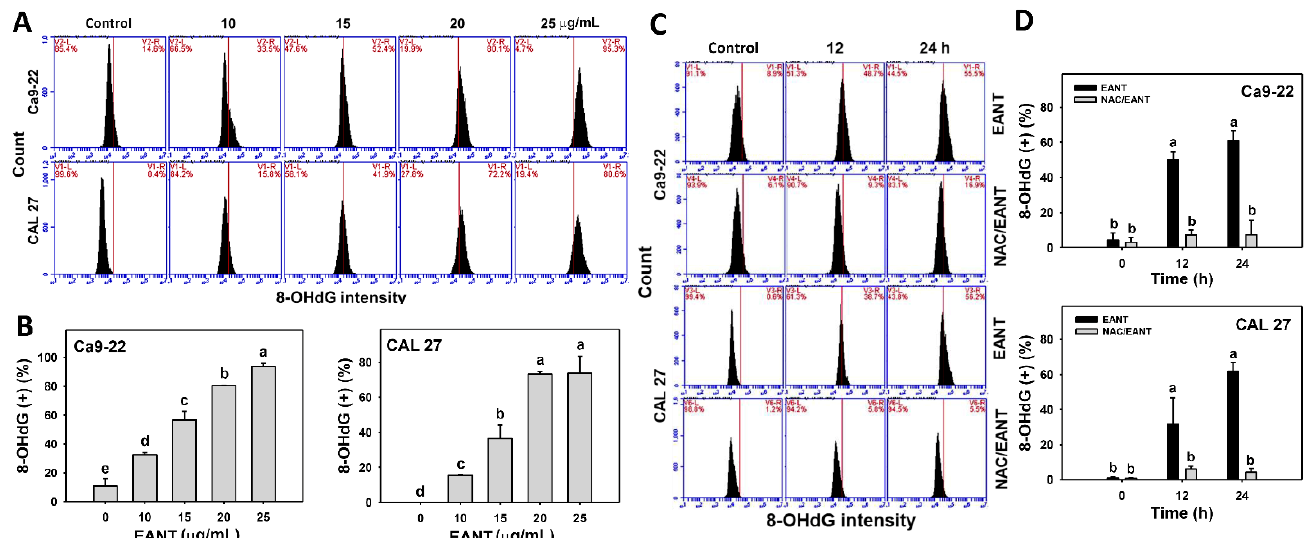
Figure 10. 8-OHdG analysis. ( A , B ) 8-OHdG pattern and statistical analysis for EANT-treated oral cancer cells (CAL 27 and Ca9-22) for 24 h. ( C , D ) NAC (2 mM) pretreatment outcome on 8-OHdG pattern and statistical analysis in EANT treatments (0 and 25 μg/mL) for 12 and 24 h. Data (means ± SD, n = 3) showing different letters on top differ significantly for multiple comparisons ( p < 0.05).